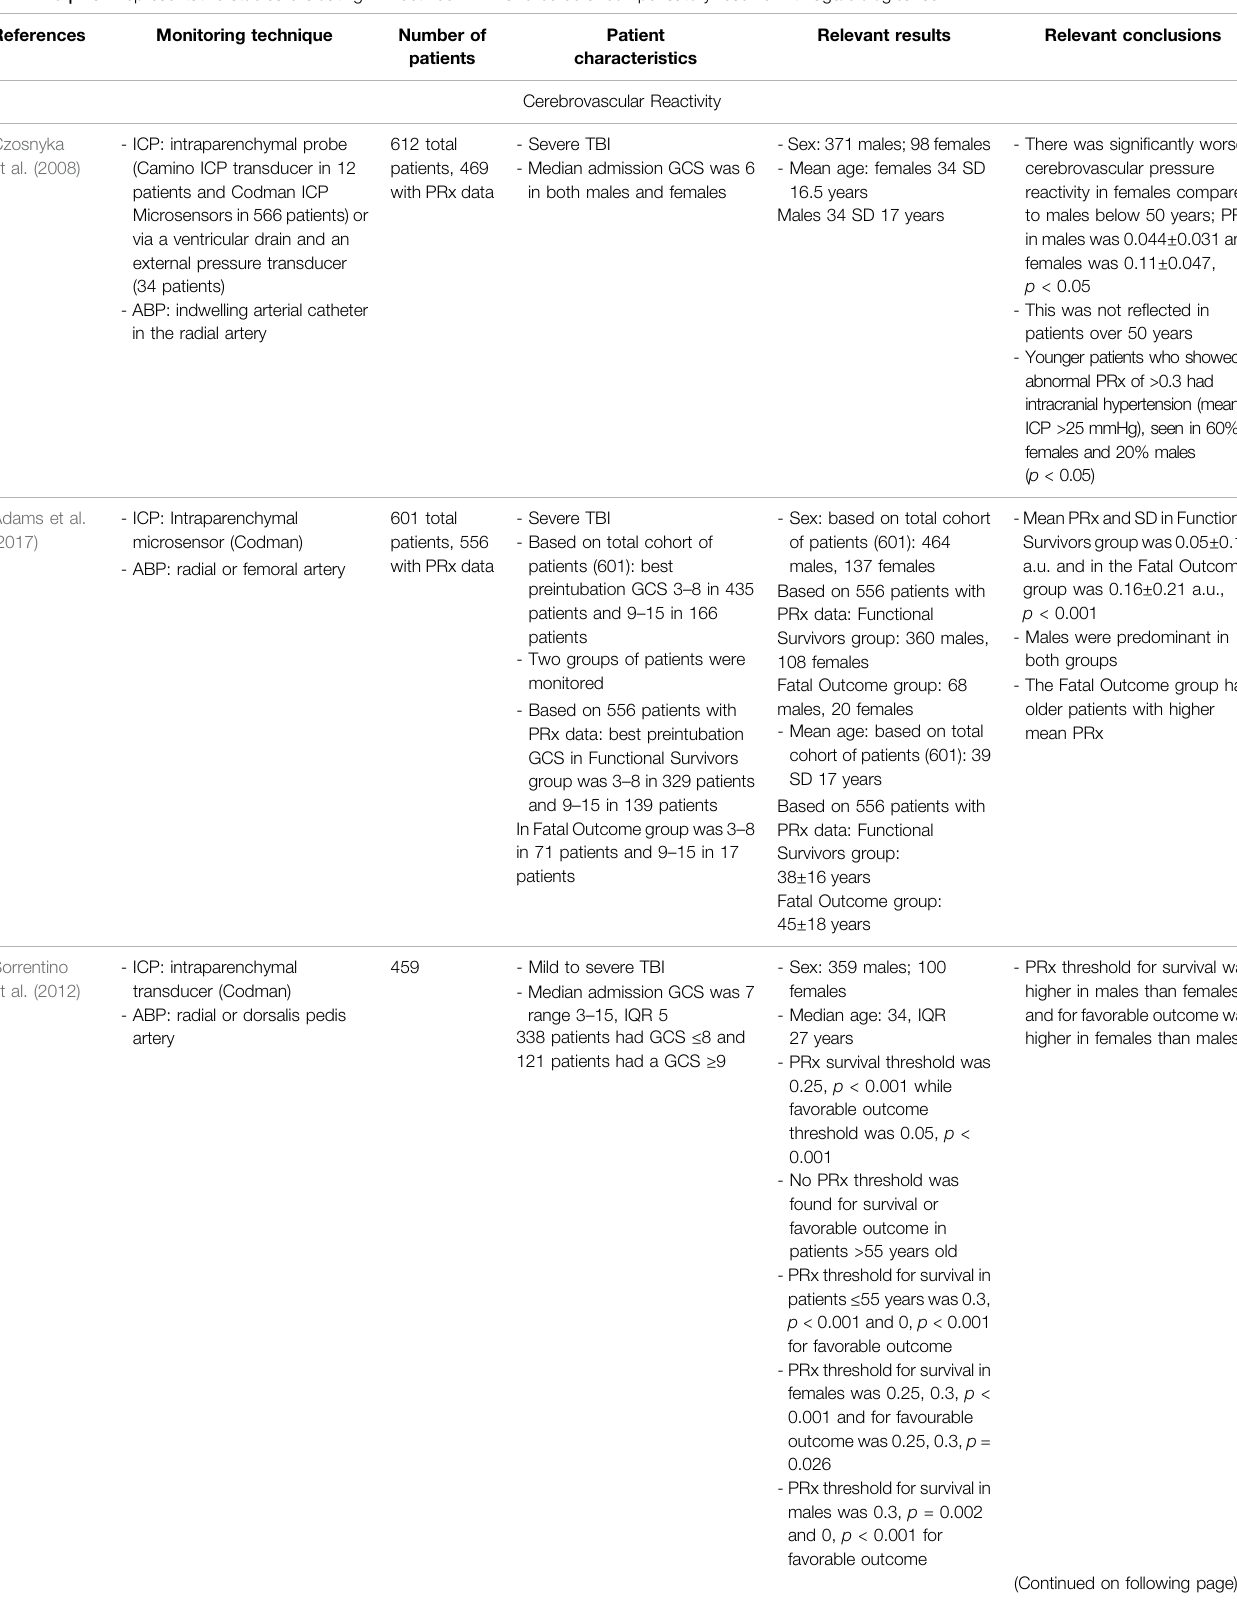
TABLE 3 | Main representative studies evaluating link between PRx and cerebral compensatory reserve with age/biological